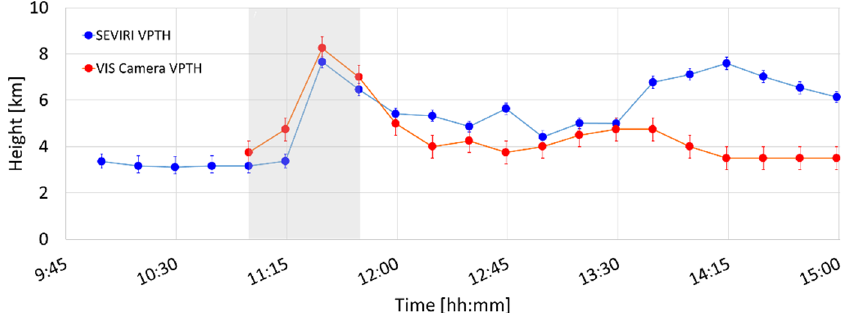
Figure 9. VPTH obtained from SEVIRI (blue line) and ECV VIS camera (red line) on 24 December 2018. The blue and red vertical bars represent the SEVIRI and VIS camera VPTH retrieval uncertainties, respectively.